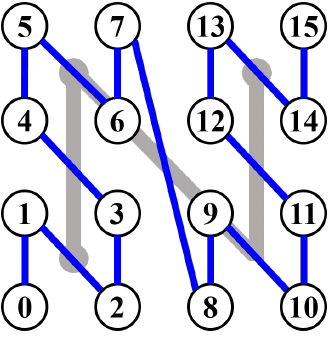
Figure 2: Morton Ordering, spatial sorting as implemented on grid data. This method is applied here to irregularly sampled data. Note the jump between points 7 and